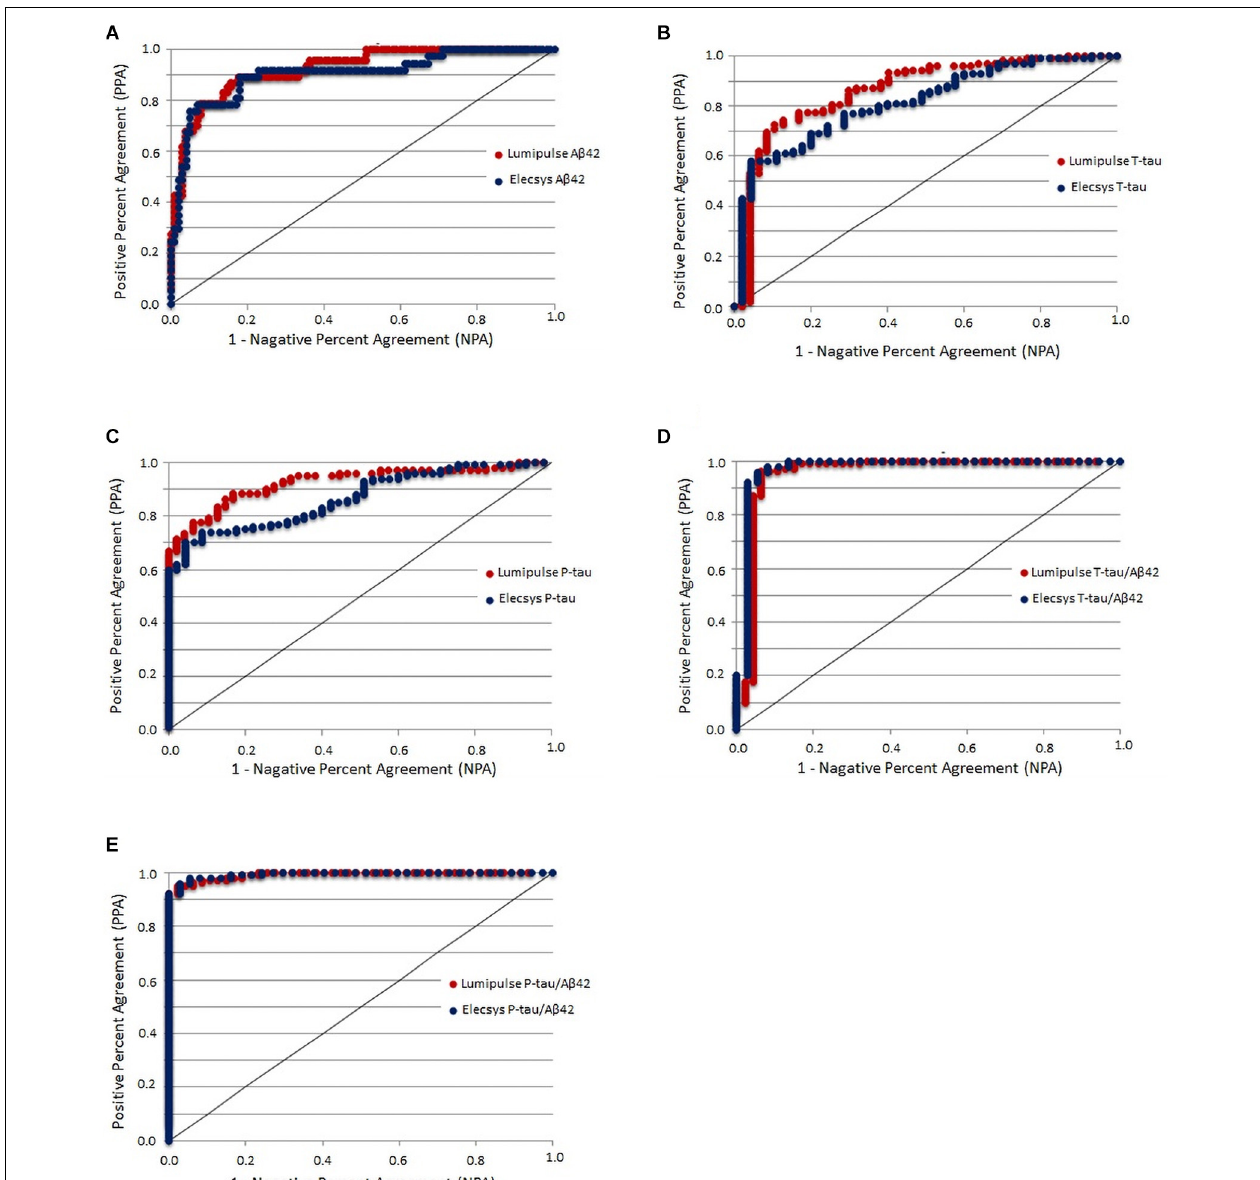
FIGURE 4 | CSF biomarkers that yielded the maximum Youden index versus A β 42/A β 40 ratio status in the receiver operating characteristics